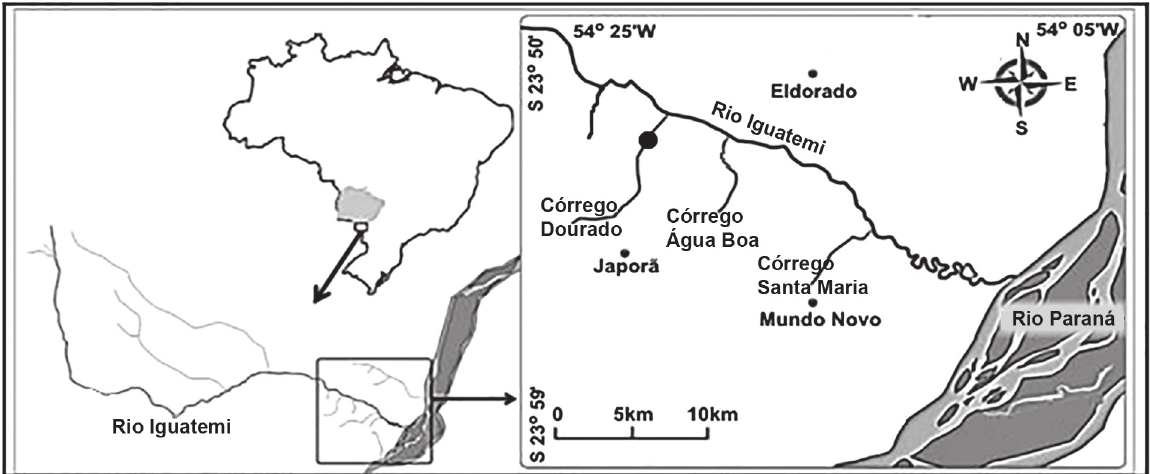
Fig. 1. Localization of córrego Dourado in the upper rio Paraná basin where specimens were captured. Black dot indicates the sampled point.